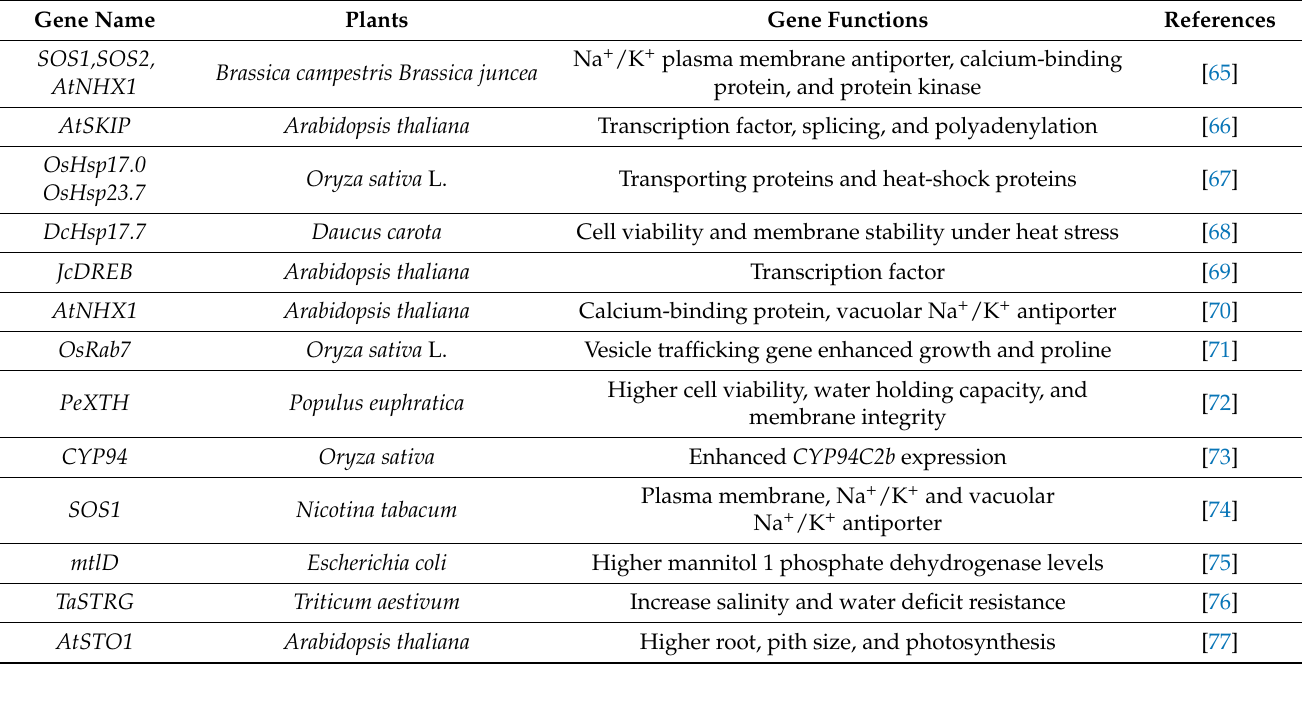
Table 2. Salt responsive genes in various plant species along with their respective gene functions.